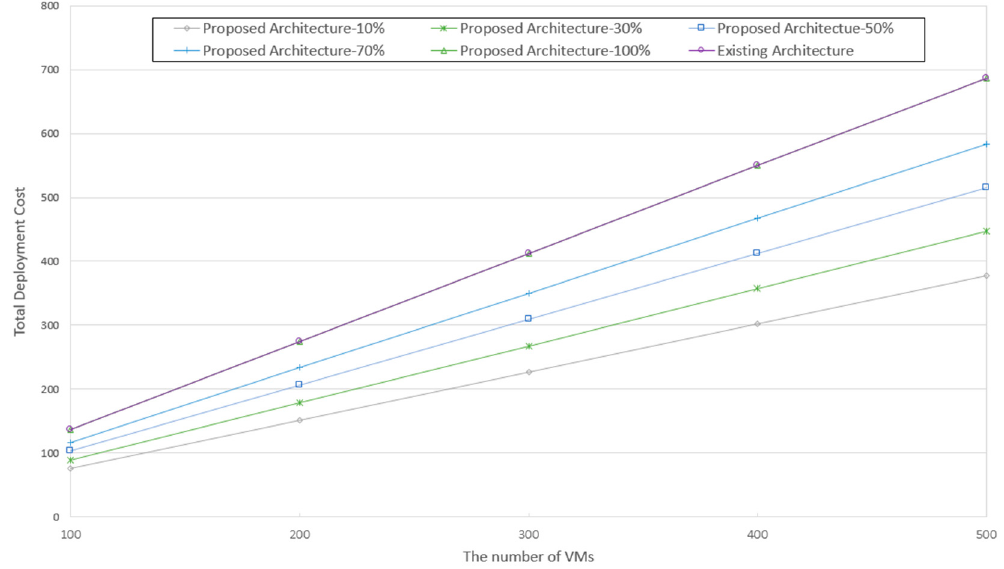
Figure 13. Comparison of recovery resource cost .